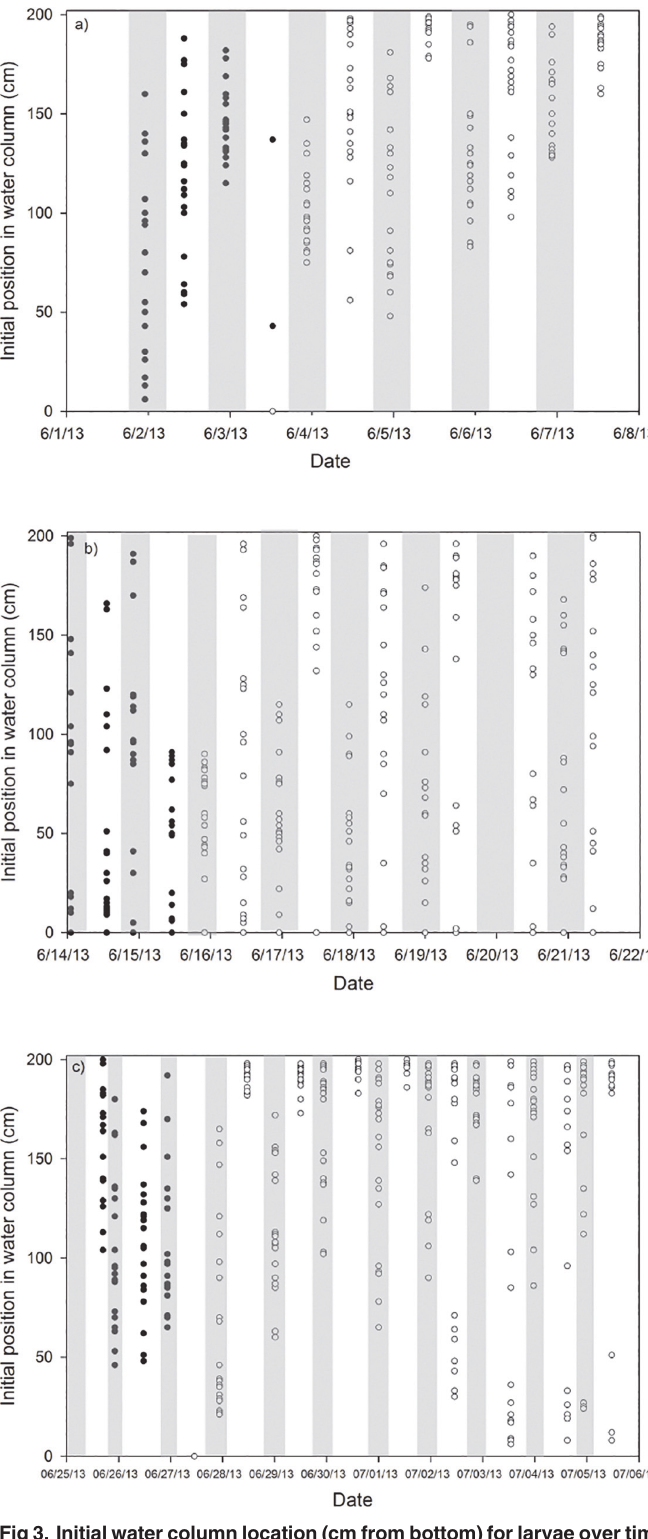
Fig 3. Initial water column location (cm from bottom) for larvae over time. Shaded areas represent night/ dark hours. Dark circles represent vertically swimming larvae and light circles represent horizontally swimming larvae.